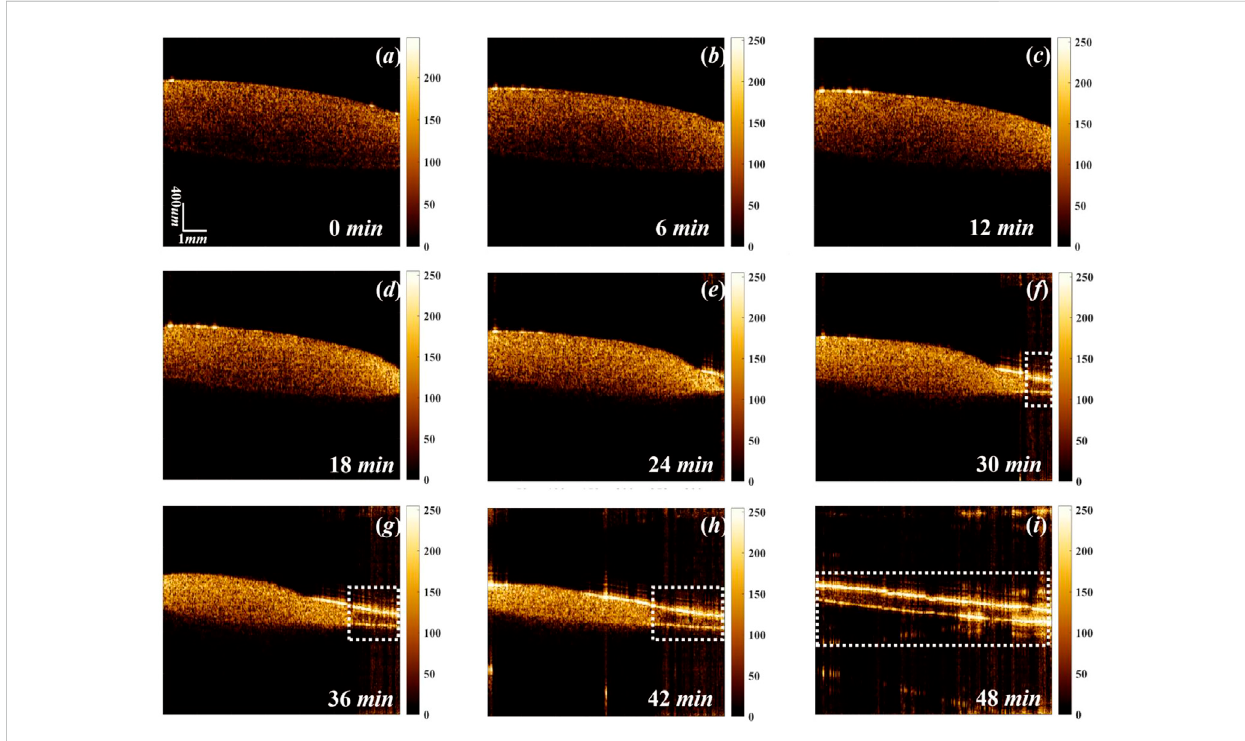
FIGURE 4 Cross-sectionalOCTimageofwholebloodduringcoagulationanddryingprocesseswithdifferentdelayingtimesof (A) 0 min, (B) 6 min, (C) 12 min, (D) 18 min, (E) 24 min, (F) 30 min, (G) 36 min, (H) 42 min, and (I) 48 min. White dot rectangles denotes the complete clot